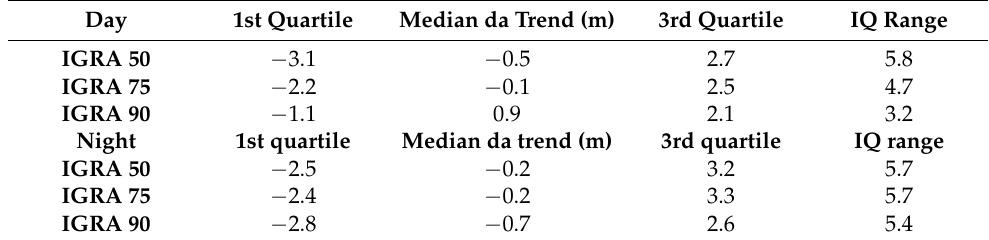
Table 1. Median, 1st quartile, 3rd quartile and interquartile (IQ) range for the same dataset shown in Figure